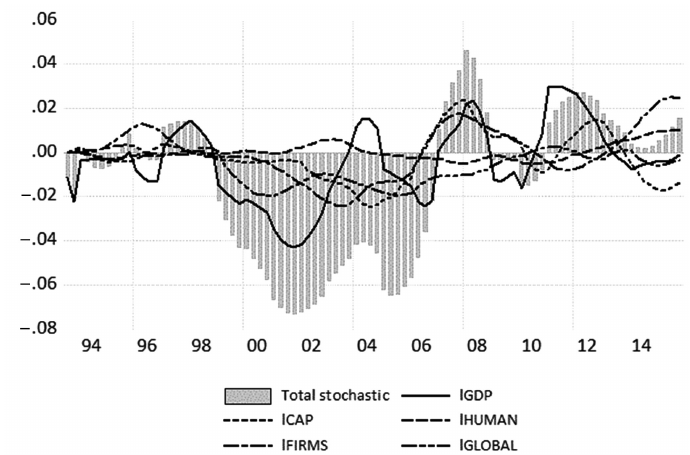
Figure 4. Variance Decomposition of lGDP (with lFIRMS) (source: authors’ calculation)